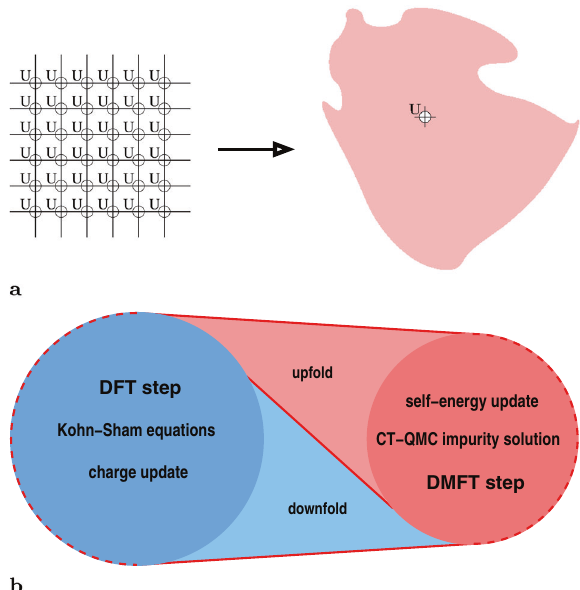
Fig. 2 Basics of the realistic-DMFT framework. a Sketch of the DMFT mapping. An interacting electron system on a lattice with a Coulomb repulsion U on each site is mapped onto a single interacting site in an energy-dependent bath. The latter is determined self-consistently in an iterative cycle. b State-of-the-art charge self-consistent DFT + DMFT loop (after 38 ). The calculation usually starts from a self-consistent Kohn-Sham solution. The correlated subspace is de fi ned and the initial Weiss fi eld G 0 constructed. Afterwards, a single DMFT step is performed. The obtained self-energies are upfolded and an updated charge density n ( r ) is computed. A new charge density implies a new Kohn-Sham potential, and a single new Kohn-Sham step is performed, therefrom a new Weiss fi eld is generated,